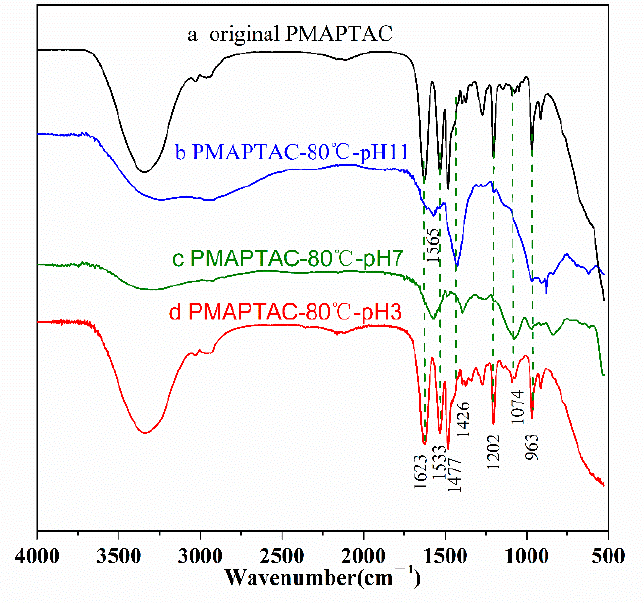
Figure 13. FTIR spectra of the original PMAPTAC and the hydrolyzed product after hydrolysis.